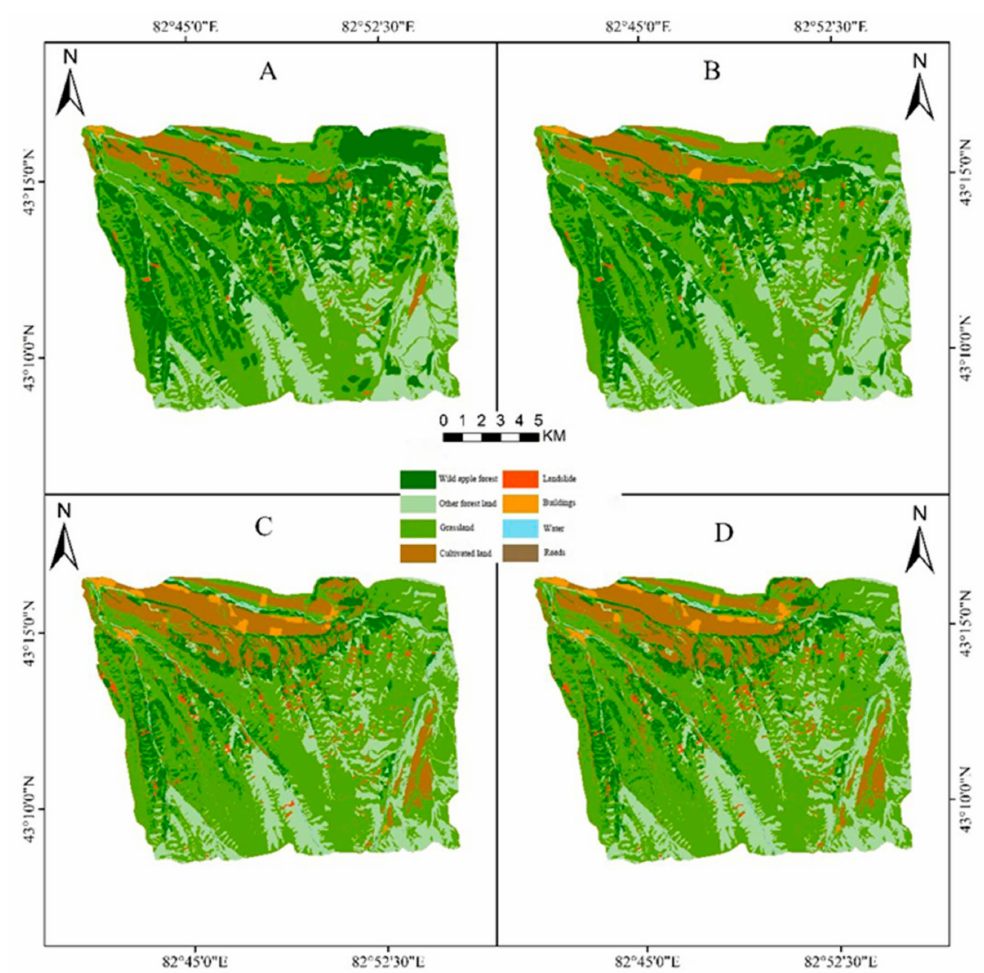
Figure 3. Temporal and spatial distribution of landscape types of Malus sieversii forest areas in the mohe watershed ( A – D are 1964, 1980, 2000, and 2017,